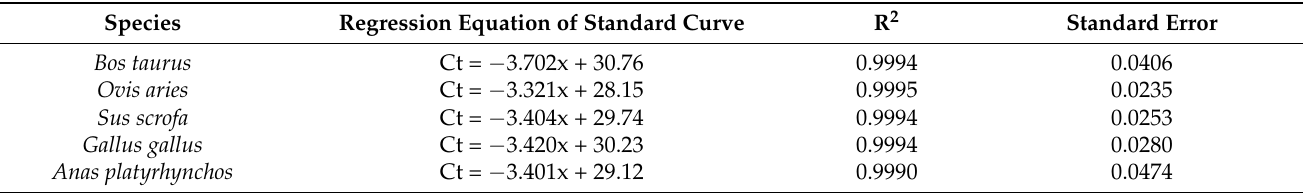
Table 4. Standard curves of five species.